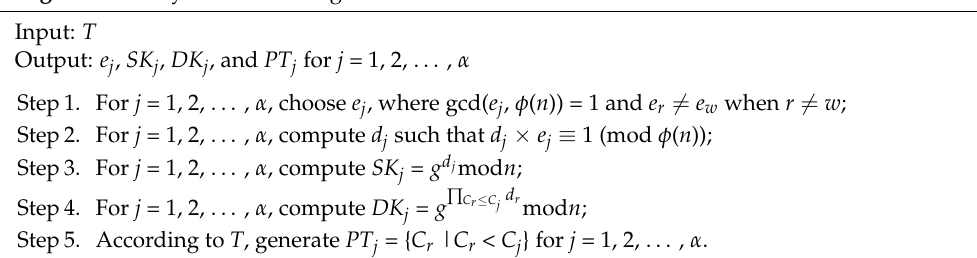
Algorithm 1 Key Generation Algorithm.